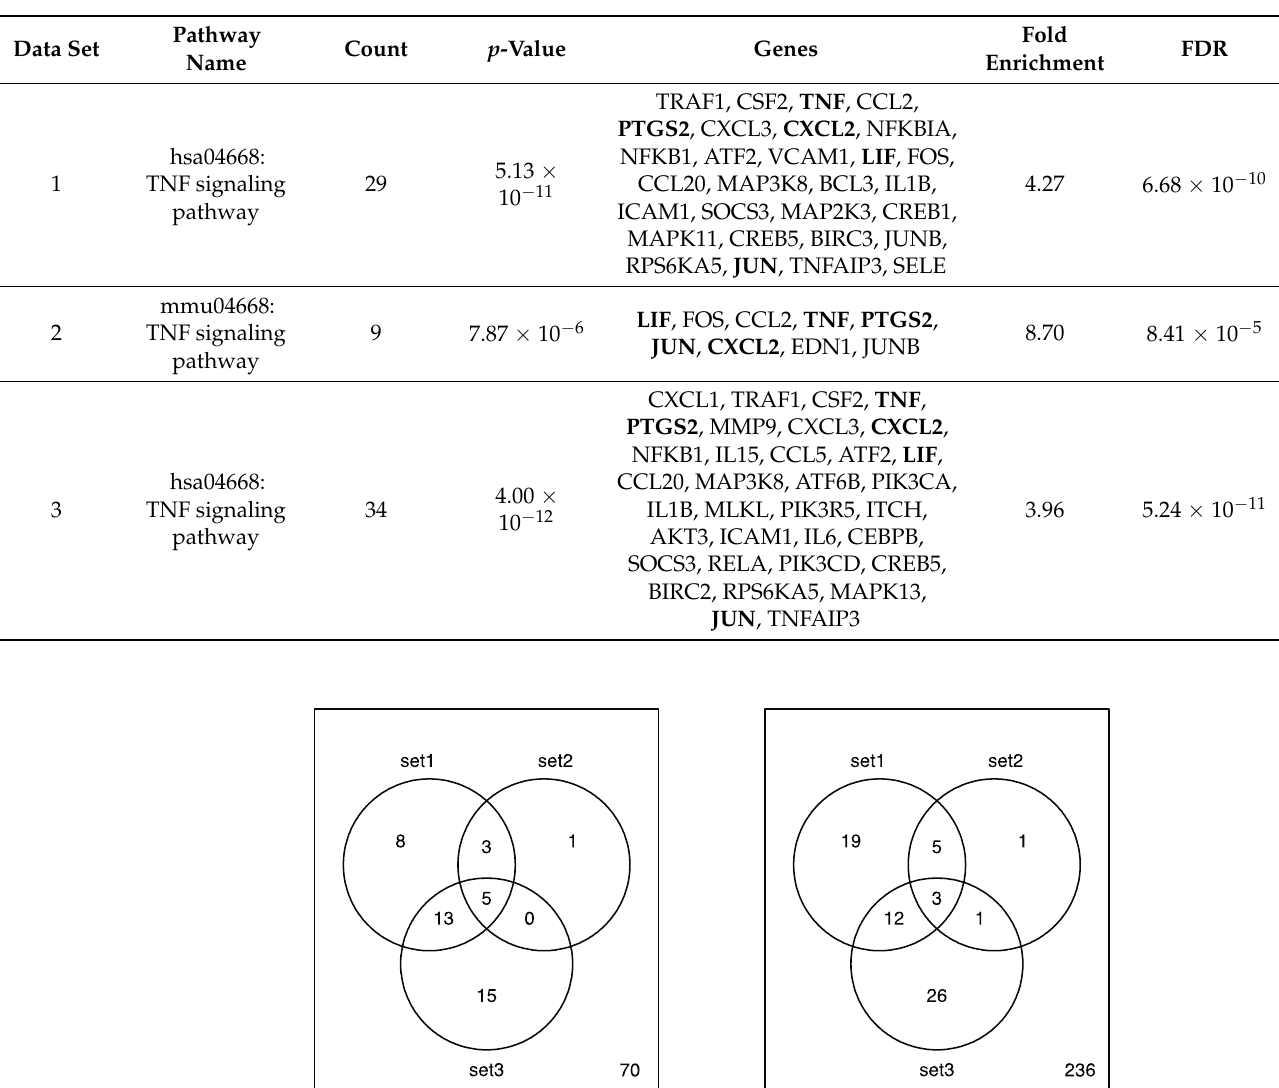
Table 2. TNF signaling Pathways identified from up-regulated genes from three microarray data sets. Common genes identified from these three data sets are highlighted.